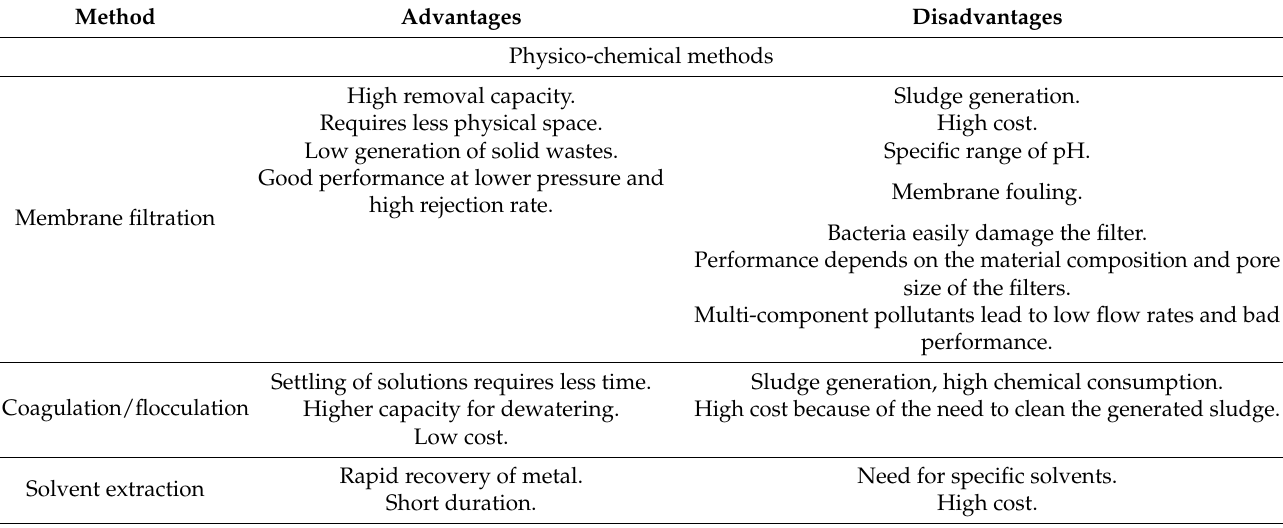
Table 1. Cr(VI) pollution treatment methods